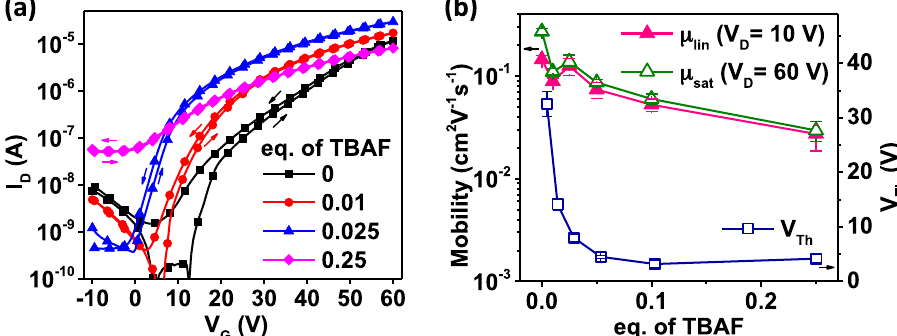
Fig. 3 a Representative plots of the transfer characteristics of transistors based on un-doped and doped P(NDI2OD-T2) at V D = 60 V; b dependence of saturation (hollow triangle) and linear ( fi lled triangle) mobility, and threshold voltage (hollow square) on doping equivalents of TBAF. The central symbol denotes the average level, and the upper and lower limit indicates standard deviation